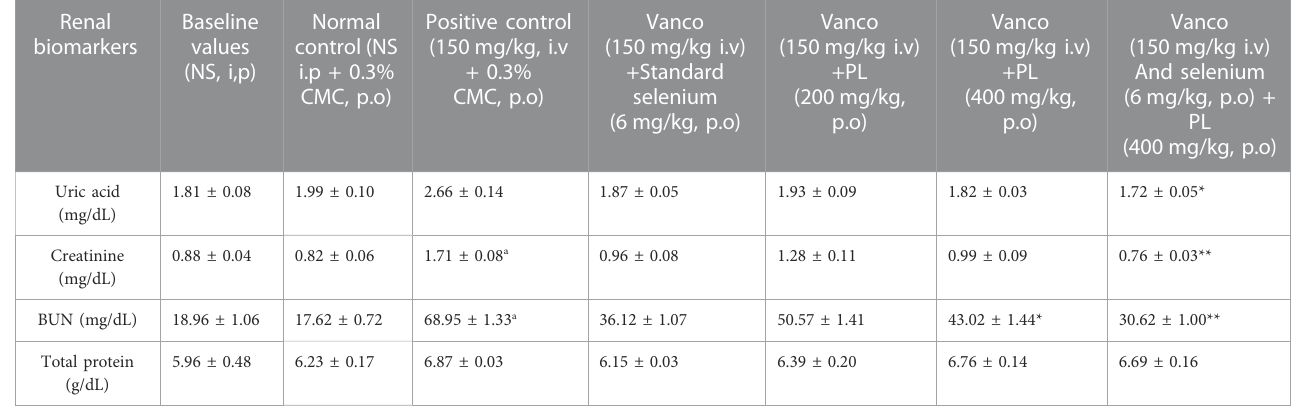
TABLE 1 Effect of curative administration of PL and selenium on the renal biomarkers in rats treated with vancomycin. Renal biomarkers